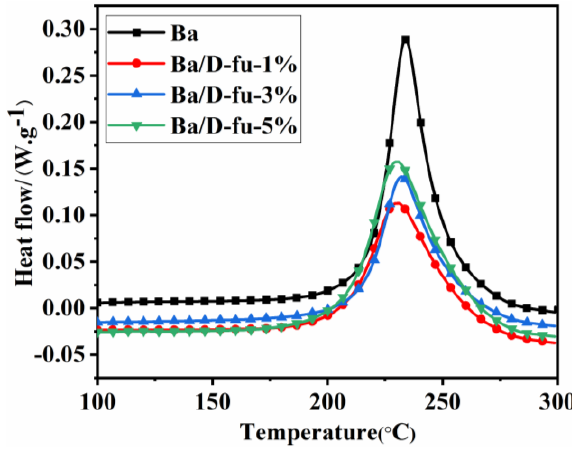
Figure 5. DSC curves for the Ba and Ba/D−fu systems at a scanning pace of 10 °C/min. Table 1. The curing parameters for Ba and Ba/D-fu systems at a heating rate of 10 °C/min.